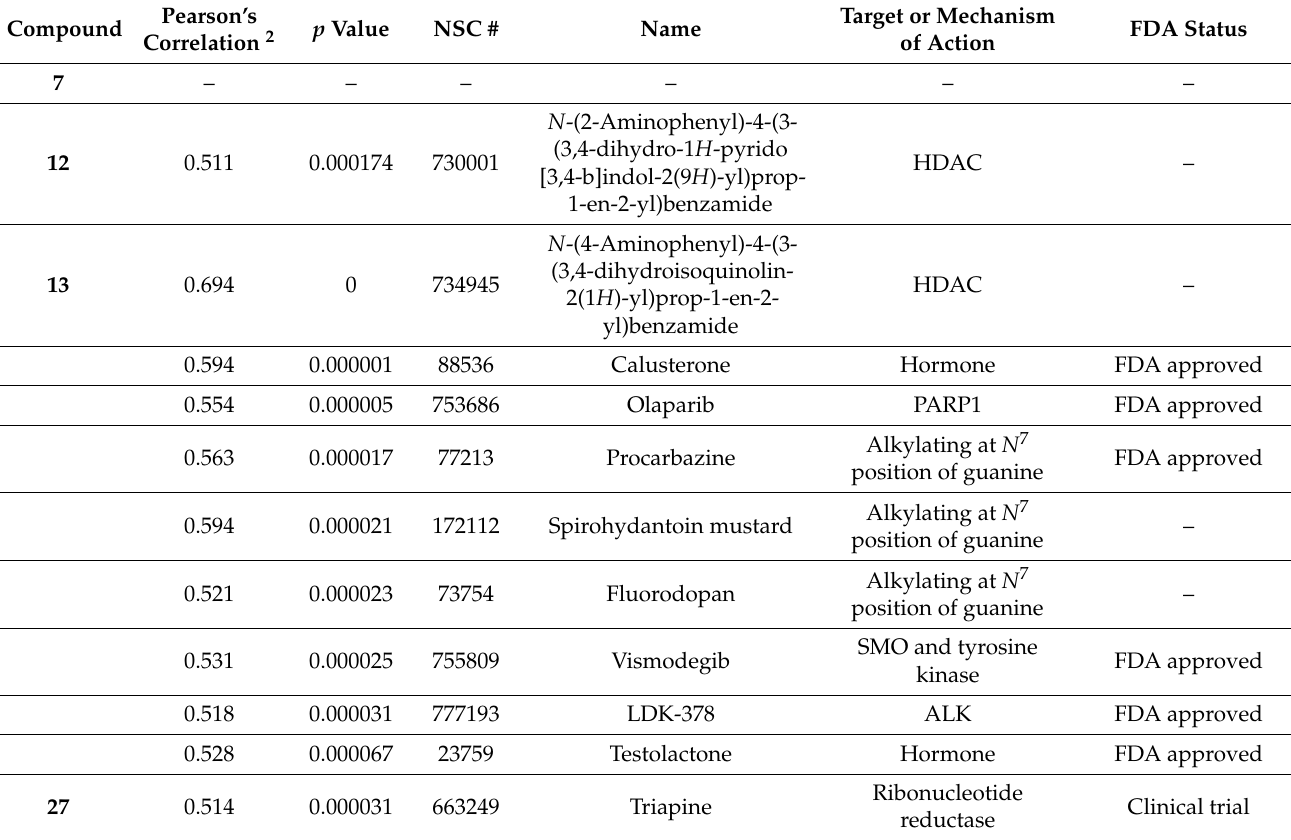
Table 5. Possible mechanism of action for the lead compounds according to CellMiner 1